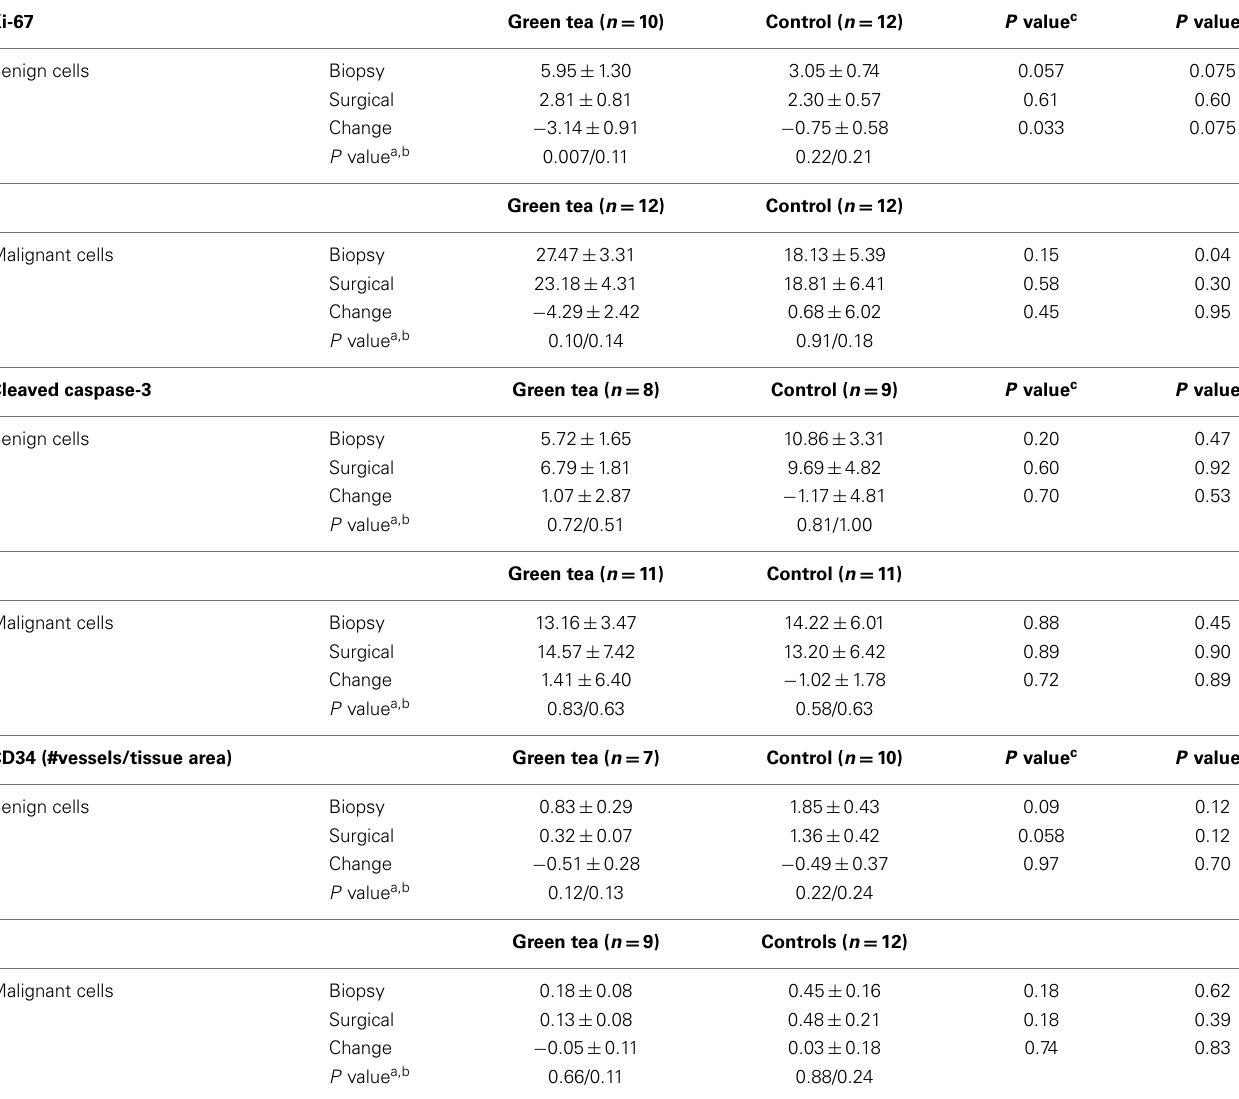
Table 2 | Diagnostic core biopsy and surgical specimen mean percent levels ( ± standard error of mean) of Ki-67, caspase-3, and CD34 in benign and malignant cell components in green tea and control